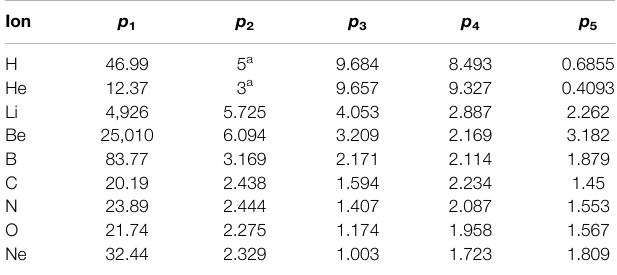
TABLE 1 | Parameters of analytical functions ( Eq. 1 ) describing the dose deposited to the cell nucleus (in Gy) per single started particle as a function of its starting energy (in